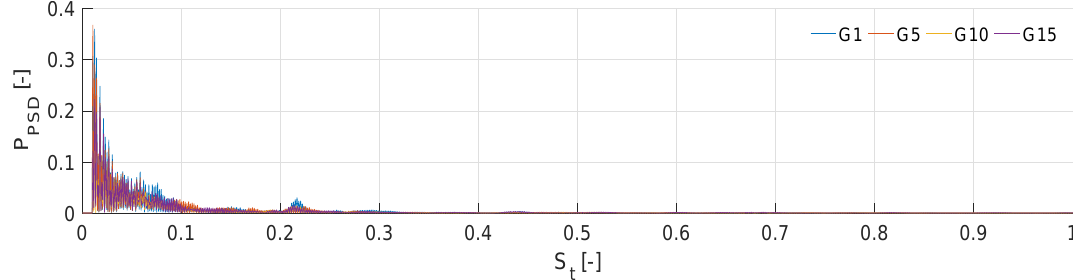
Figure 20. Normalized power-spectra of the pressure signals of circumferential points in the guide vane domain.